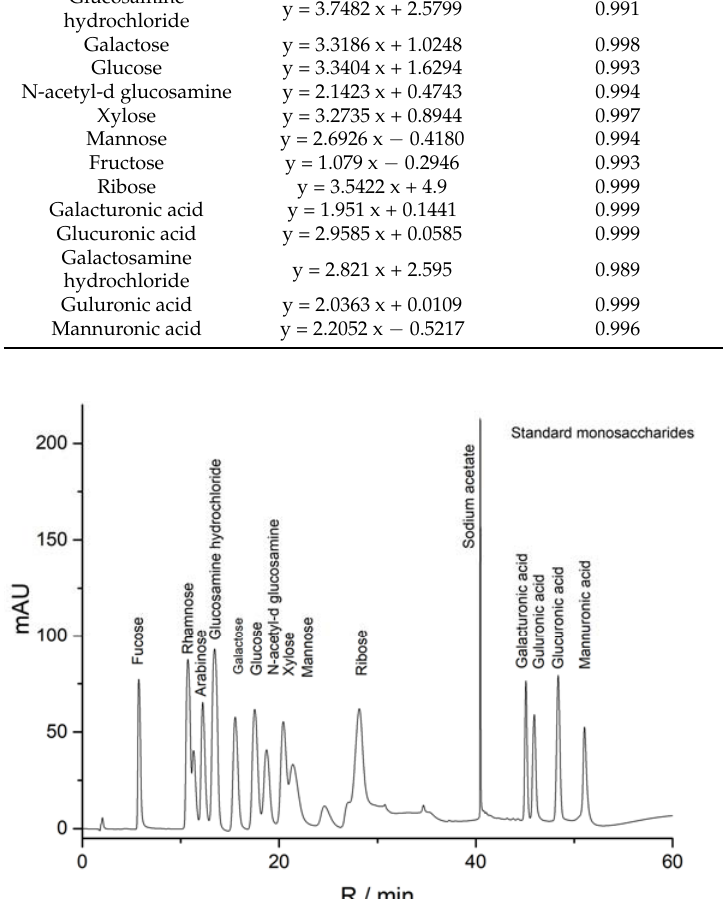
Figure 6. HPAEC profiles of standard monosaccharides.